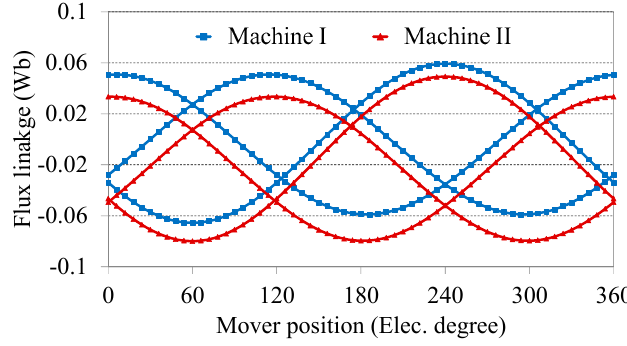
Figure 4. 3-phase PM flux linkage waveforms of Machine I and Machine II.